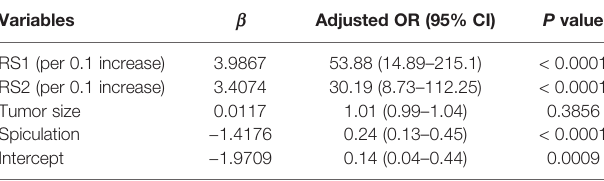
TABLE 2 | Variables and coef fi cients of the radiomics nomogram. Variables b Adjusted OR (95% CI) P value RS1 (per 0.1